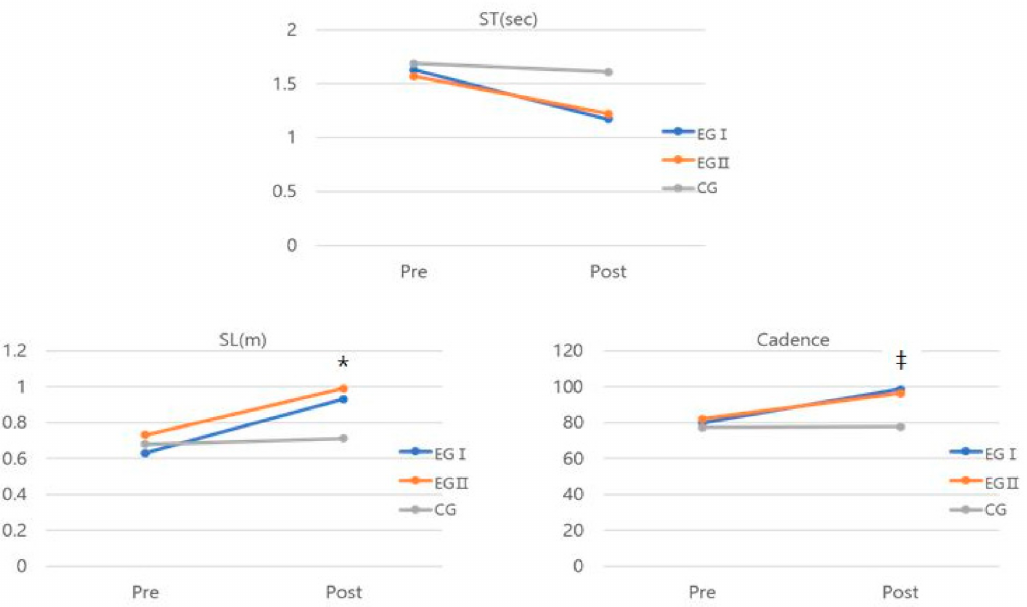
Figure 3. Comparison of gait function for each group. * Significant difference between the EGI and CG, EGII and CG. ‡ Significant difference between the EGI and